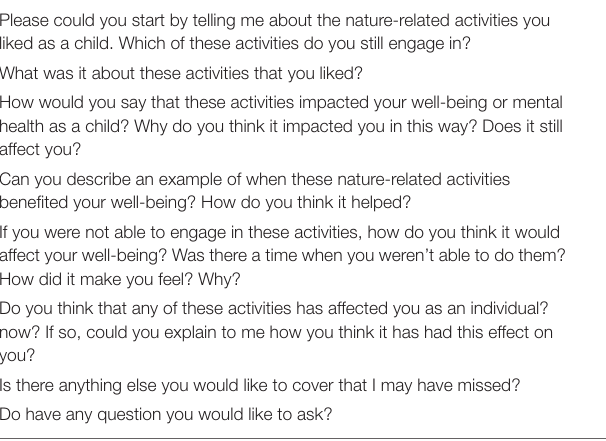
TABLE 4 | Topic guide for the semi-structured interview